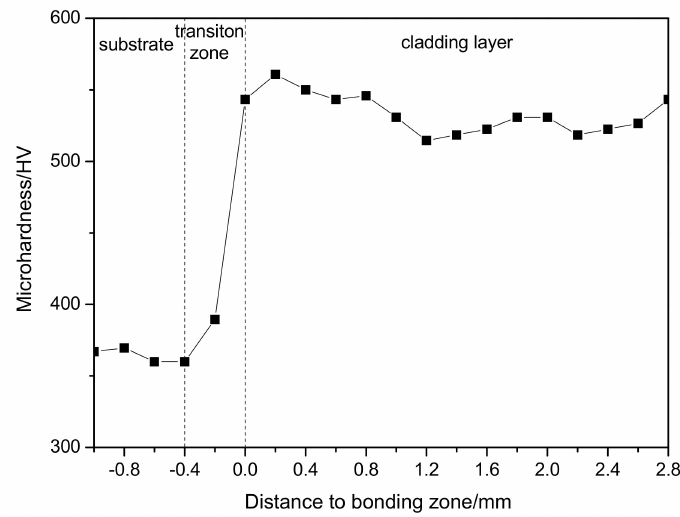
Figure 5. Microhardness of MoNbTaWTi Arc Surfacing